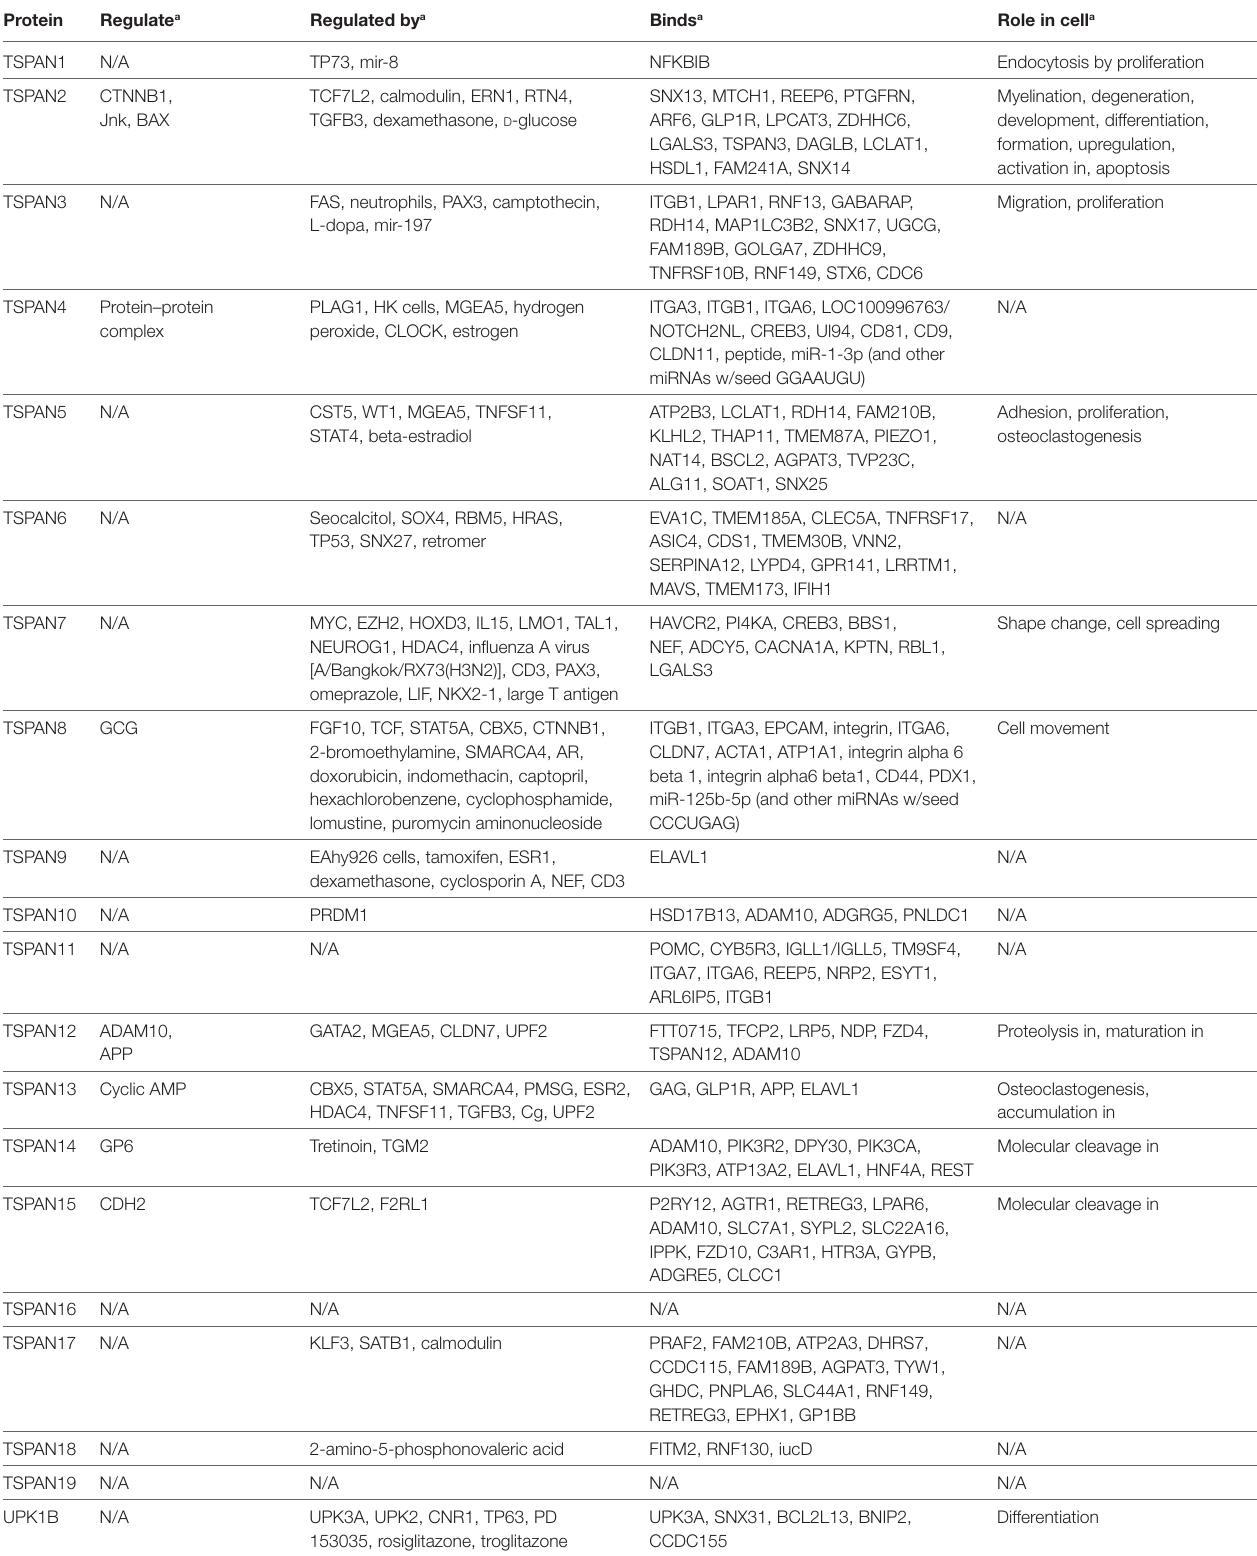
TABLe 1 | The regulation and function of tetraspanins and their interacting partners.